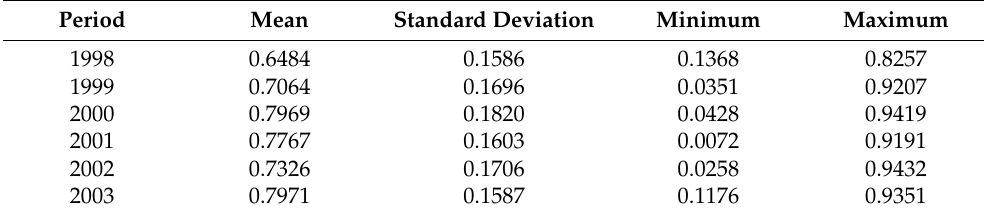
Table 3. Annual efficiency scores of U.S. oil and gas